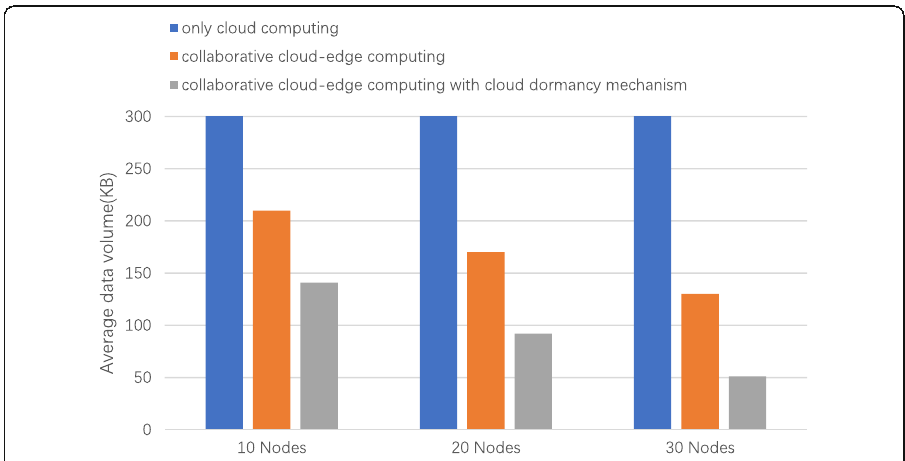
Fig. 8 Average data volume of different schemes. The comparison of the average data volume uploaded from only cloud computing scheme, collaborative cloud-edge computing scheme, and the scheme with cloud dormancy